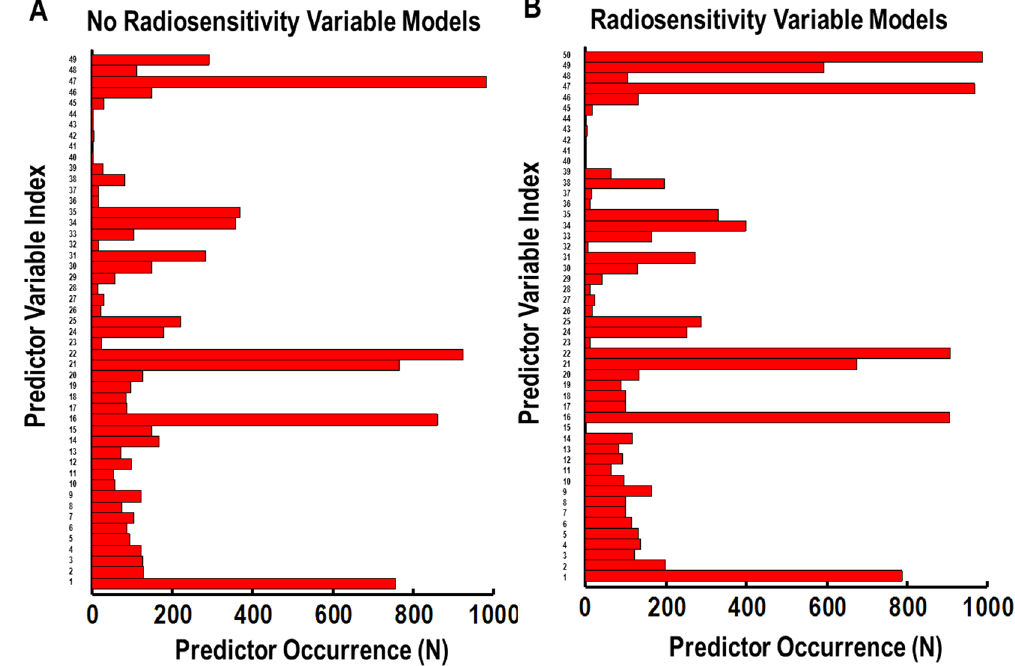
Figure 4. Bar charts of the occurrence of predictors for all 1000 iterations of the LASSO logistic regression toxicity prediction- modelling construction process. Models created without the radiosensitivity predictor are described in ( A ), and models using the radiosensitive tag variable from K-Means clustering of expansion- response at the end of radiotherapy are shown in ( B ). The predictor index number identifies the specific predictor variable from Table 2.